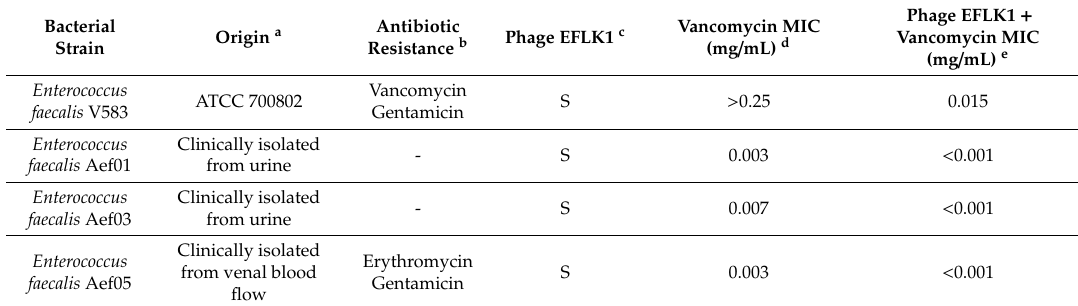
Table 1. Bacterial strains and their sensitivities to phage EFLK1, vancomycin and combined treatment. Bacterial